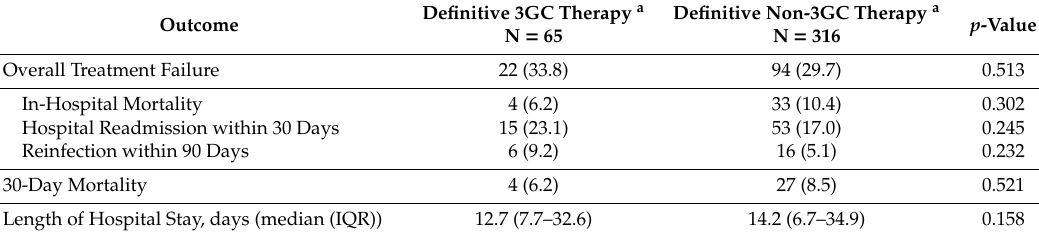
Table 4. Clinical outcomes by therapy